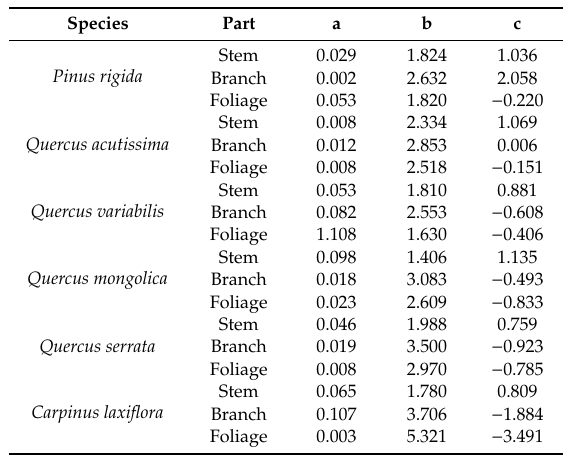
Table 3. The coe ffi cients for allometric equations of each part of the species [37]. Y = aD b H c was used for allometric equations, where D is DBH, H is tree height, and Y is dry weight. The coe ffi cients for allometric equations were developed for over 6 cm of DBH